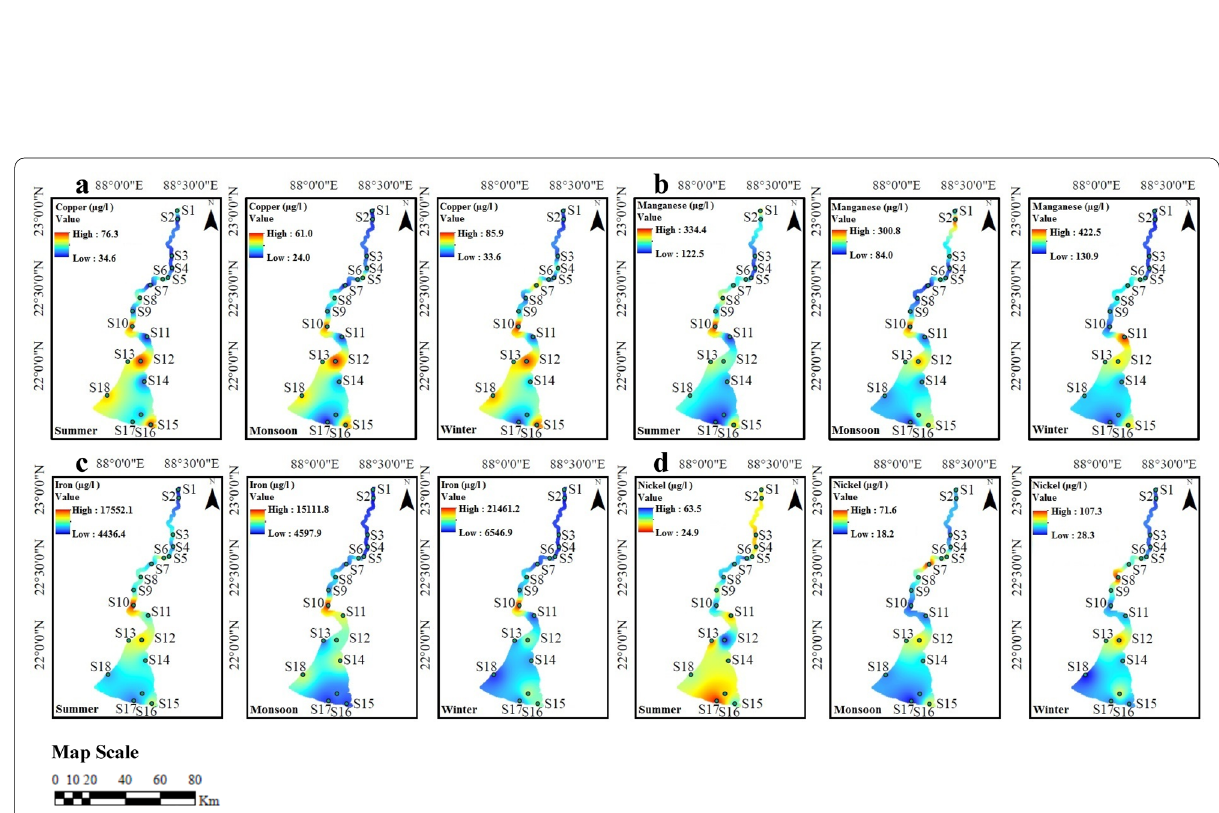
Fig. 3 Geospatial distribution of Copper (Cu), Manganese (Mn), Iron (Fe), and Nickel (Ni) in river Hooghly. a Cu, b Mn, c ) Fe, and d